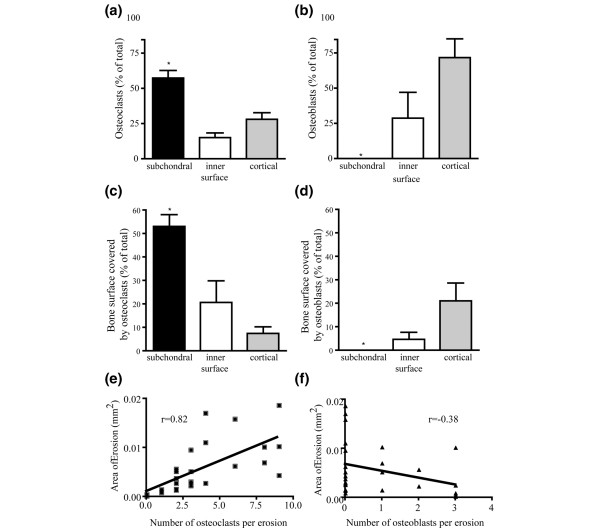
Distribution of osteoclasts and osteoblasts within local bone erosions. Paraffin-embedded sections of hindpaws of mice transgenic for human tumor necrosis factor were simultaneously stained for (a, c) osteoclasts and (b, d) osteoblasts. The distribution and density of osteoclasts and osteoblasts were assessed in three different compartments within bone erosions: the surface adjacent to the articular cartilage (subchondral surface), the inner frontier of erosion (inner surface), and the surface adjacent to cortical bone (cortical surface). The size of local bone erosions was correlated to the numbers of (e) osteoclasts and (f) osteoblasts within these lesions. Spearman's correlation coefficients are given. The numbers of osteoclasts correlated positively (r = 0.82, P < 0.0001) with the area of bone erosion, whereas the numbers of osteoblasts correlated negatively (r = -0.38, P < 0.05).